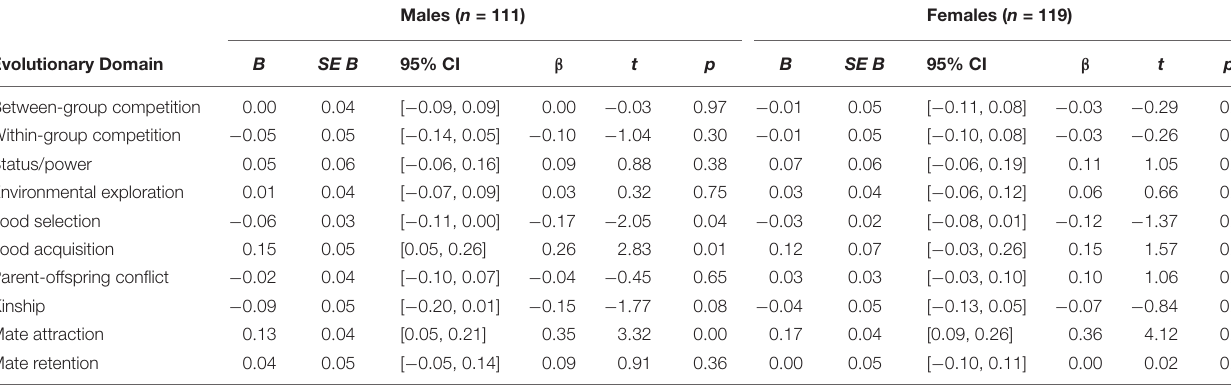
TABLE 8 | Multiple regression analysis for expected benefit-context predicting risk-taking behaviors.